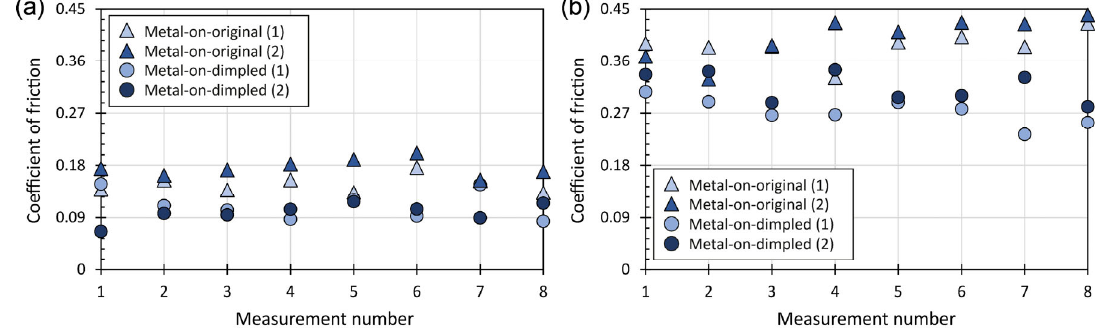
Fig. 4 Results of friction coefficient for metal femoral head using (a) PBS and (b) model SF.